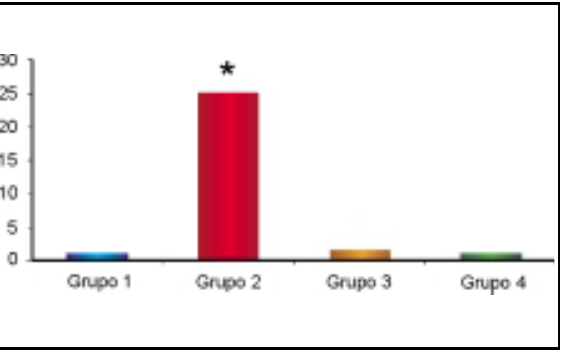
FIGURA 4 - Gráfico apresentando os valores da Gama- Glutamil Transpeptidase (GGT - U/L). (* = p < 0.05).